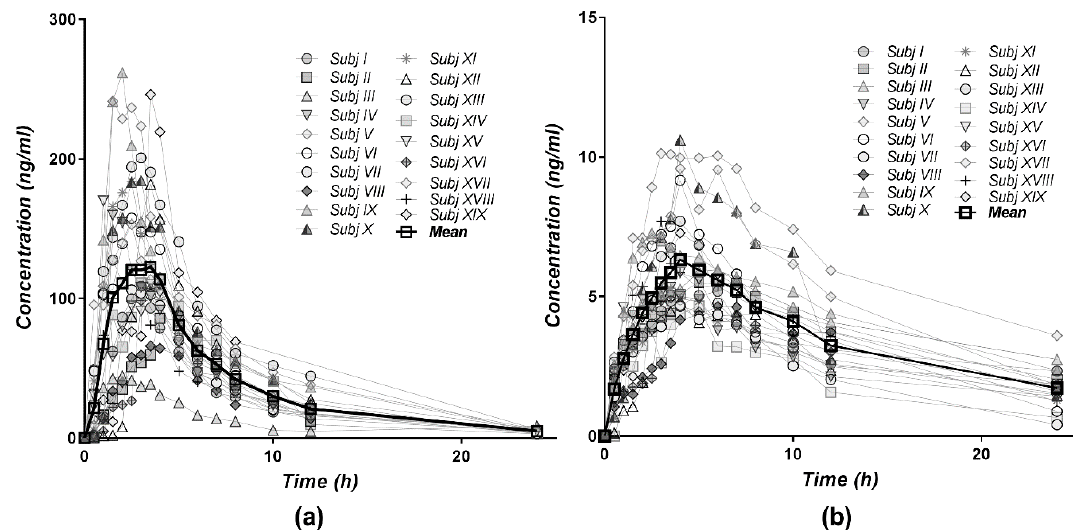
Figure 3. Individual and mean plasma concentration–time profiles for ( a ) DTZ and ( b ) DTZM after single dose oral administration of 120 mg diltiazem (2 × 60 mg Cardiazem ® tablets) to 19 healthy subjects.